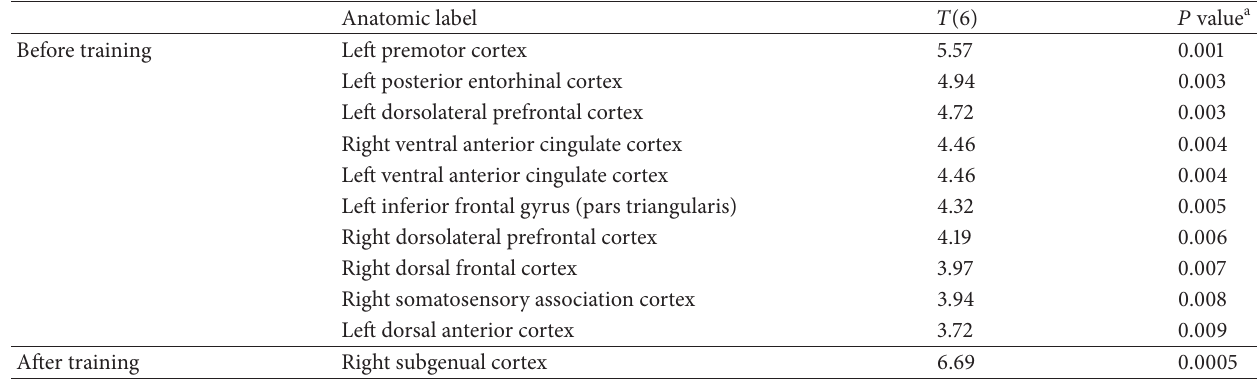
Figure 2: Functional connectivity during sniffing for anosmic patients before (a) and after (b) the smell training performed over 12 weeks, overlaid on an axial template in MNI space ( 𝑃 = 0.01 , uncorrected). The green dot represents the selected ROI (piriform cortex); the red dots capture the statistically significant functionally connected brain areas. (1) Dorsolateral prefrontal cortex (l). (2) Dorsal anterior cortex (l). (3) Inferior frontal gyrus (l). (4) Ventral anterior cortex (l). (5) Premotor cortex (l). (6) Posterior entorhinal cortex (l). (7) Dorsolateral prefrontal cortex (r). (8) Dorsal frontal cortex (r). (9) Dorsolateral prefrontal cortex (r). (10) Ventral anterior cortex (r). (11) Somatosensory association cortex (r). (12) Subgenual cortex (r). Table 2: Intensity of functional connectivity with the